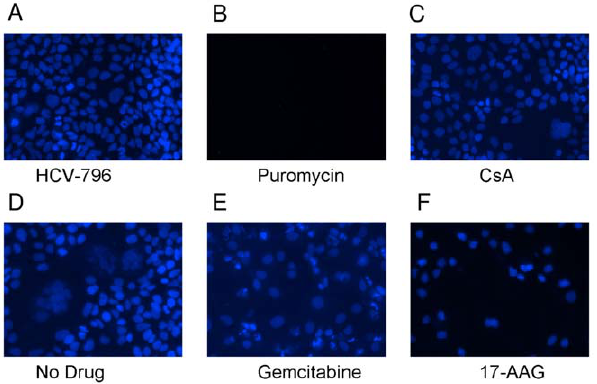
Figure 4. Visual assessment of replicon cell number and morphology after 1 m M compound treatment. Hoechst-stained nuclei were visualized after treatment for three days with the following molecules: (A) the HCV polymerase inhibitor HCV-796, (B) the ribosomal inhibitor puromycin, (C) the cyclophilin inhibitor CsA, (D) the microtubule inhibitor colchicine, (E) the anti-metabolite gemcitabine, and (F) the HSP90 inhibitor 17-AAG.